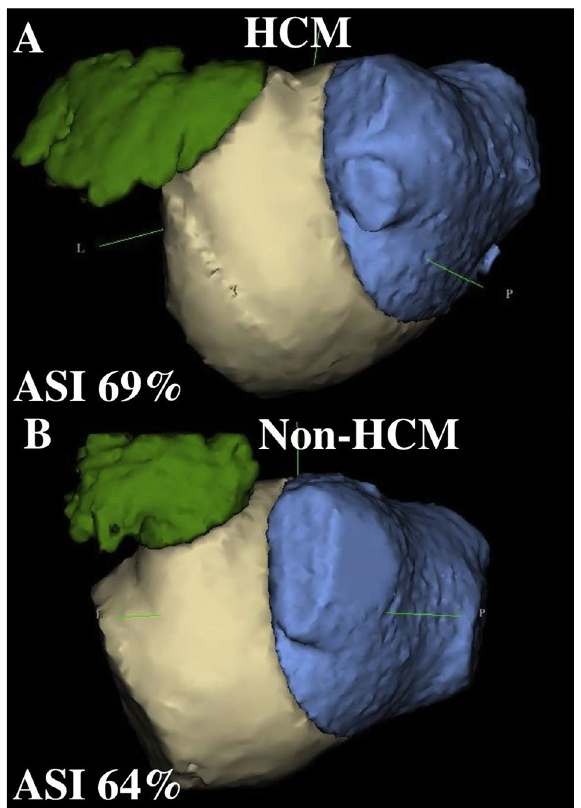
Figure 4. Asymmetry index (ASI) in a patient with ( A : ASI 69%, LAV 130 ml) and one without ( B : ASI 64%, LAV 125 ml) hypertrophic